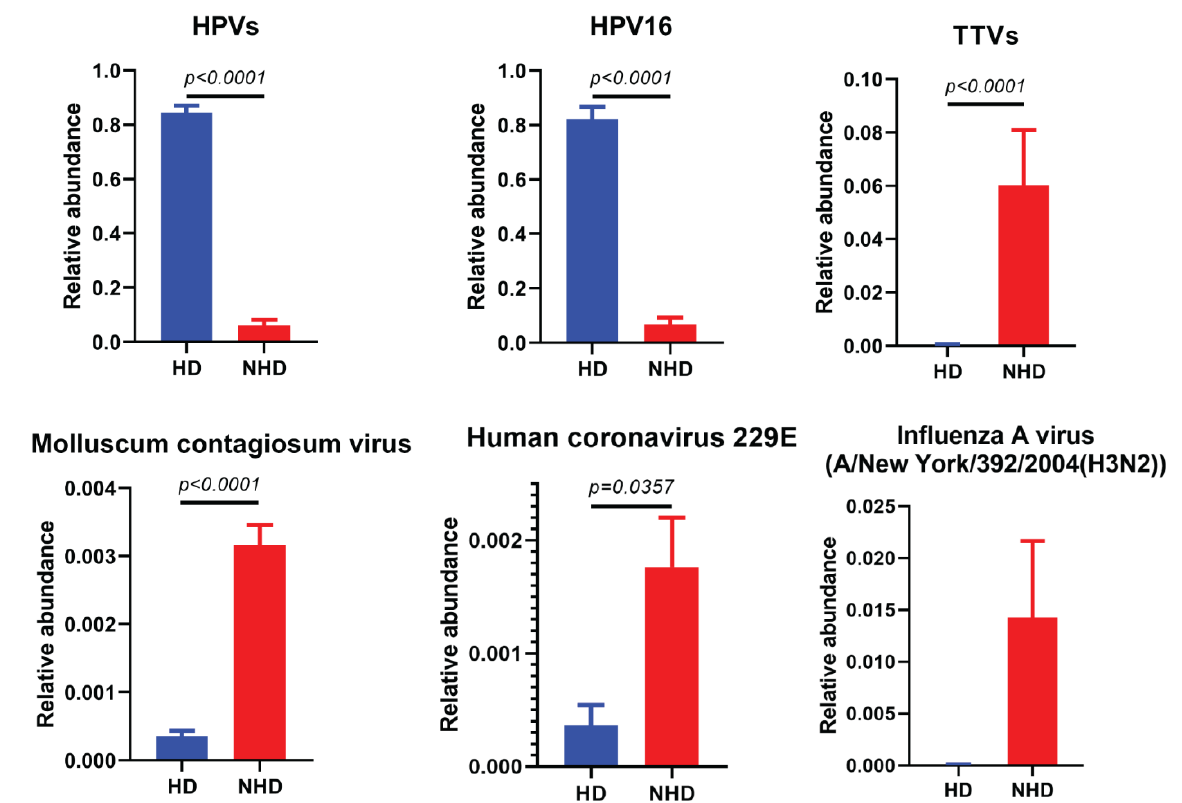
Figure 4. Relative abundances of selected taxa of human viruses between HD and NHD groups. Error bars indicate the standard error of mean (SEM). Mann-Whitney U testing for non-parametric data was used for comparison between the abundance of each group.